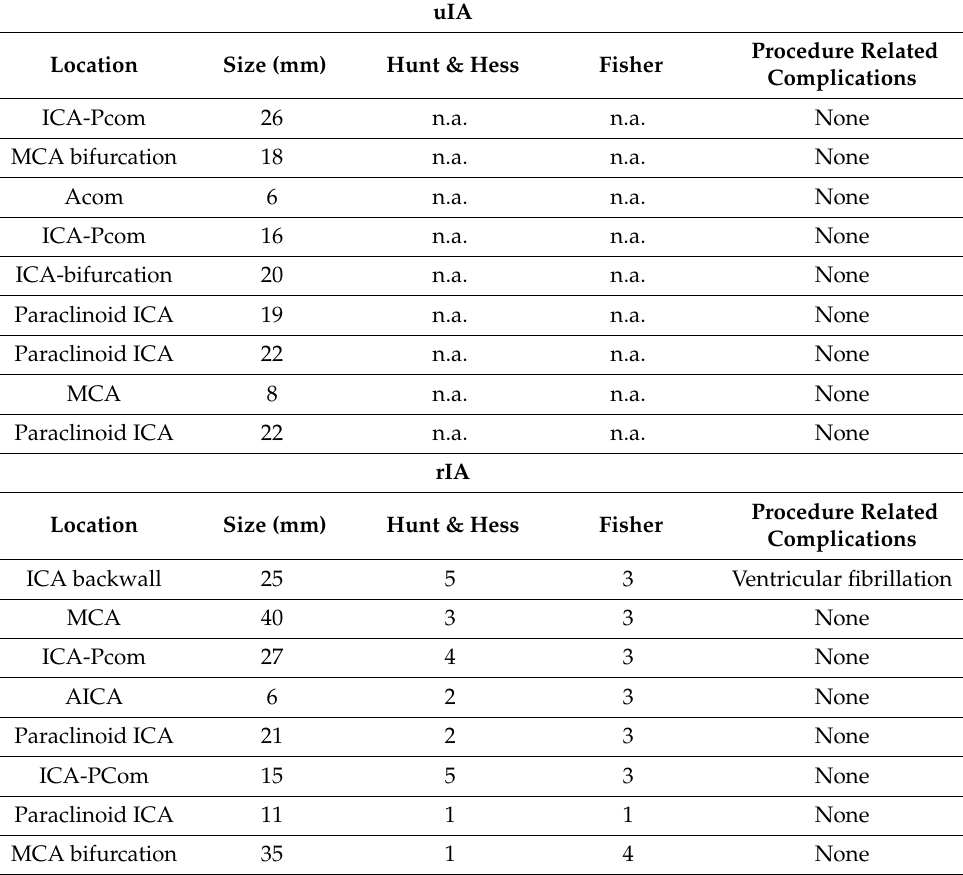
Table 2. Aneurysm characteristics.